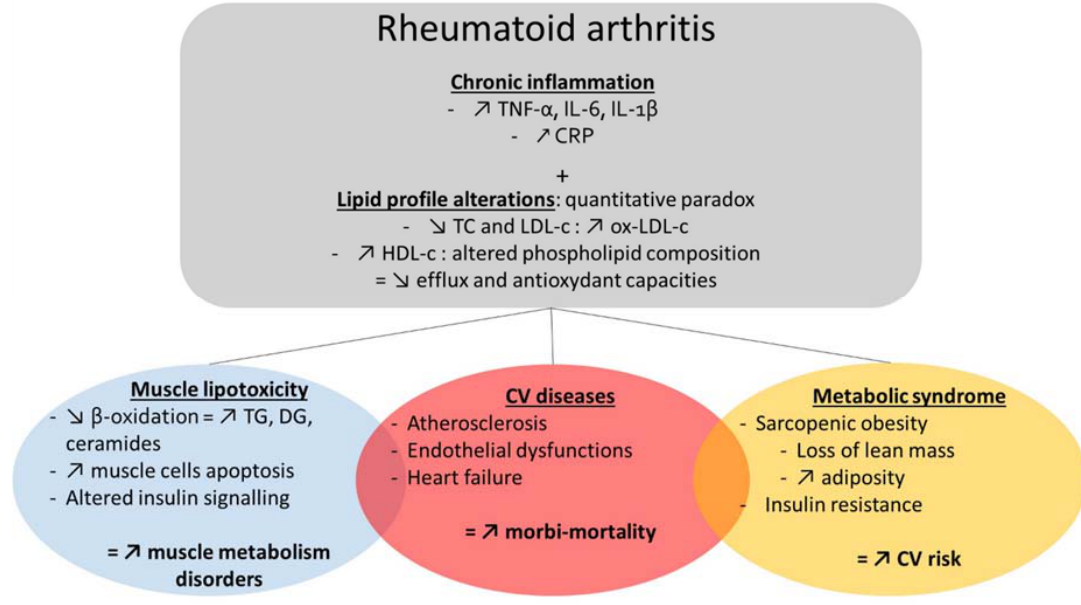
Figure1. Comorbiditiesinrheumatoidarthritis(RA).RAisachronicinflammatorydiseasecharacterized by alterations in lipid profile, a high prevalence of metabolic syndrome, sarcopenic obesity, insulin resistance, altered insulin signaling and disorders in muscle lipid metabolism. All of these perturbations contribute to CV disease and thus, to an increased morbi-mortality in RA patients. CRP: C—reactive protein; CV: Cardiovascular; DG: Diglycerides; HDL-c: High-density lipoprotein-cholesterol; IL-6: interleukine-6; IL-1 β : interleukine-1 β ; LDL-c: Low-density lipoprotein-cholesterol; ox-LDL-c: oxidized low-density lipoprotein-cholesterol; TC: Total cholesterol; TG: Triglycerides; TNF- α : Tumorous Nuclear Factor α